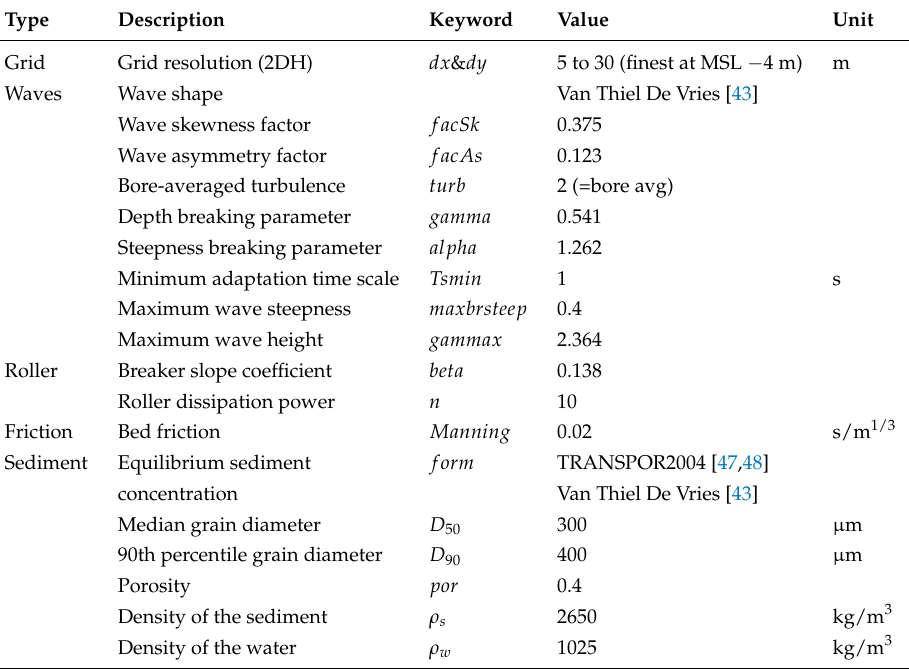
Figure 3. Methodology for computing volumetric change at shoreface nourishments using lookup table of computed initial erosion rates. Table 2. Overview of settings used in the XBeach